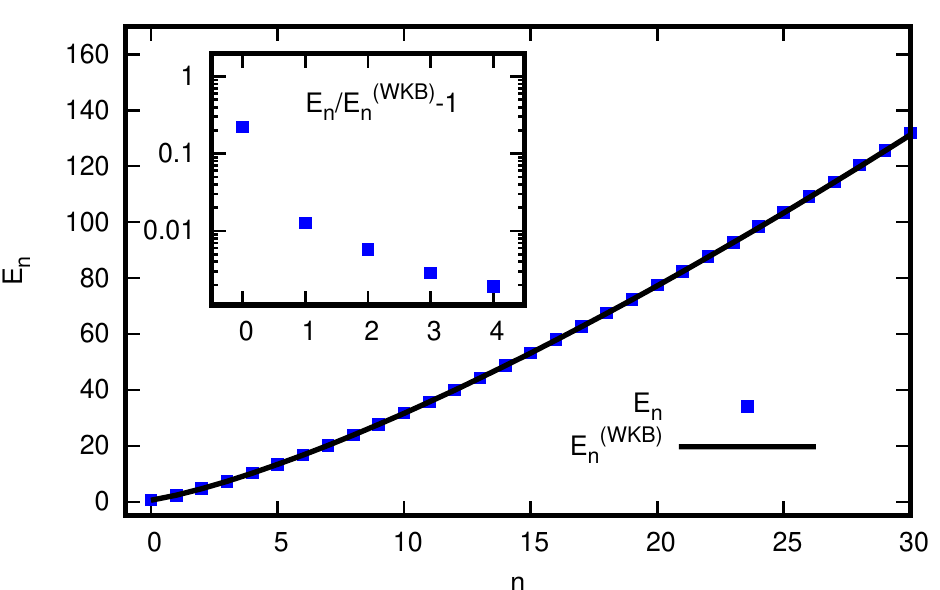
Figure 1 . Eigenvalue spectrum E n of the anharmonic quartic oscillator, compared to the WKB approximation as a function of n . Inset shows E n /E (WKB) n − 1 to demonstrate that eigenvalues rapidly converge to the WKB values (note the logarithmic